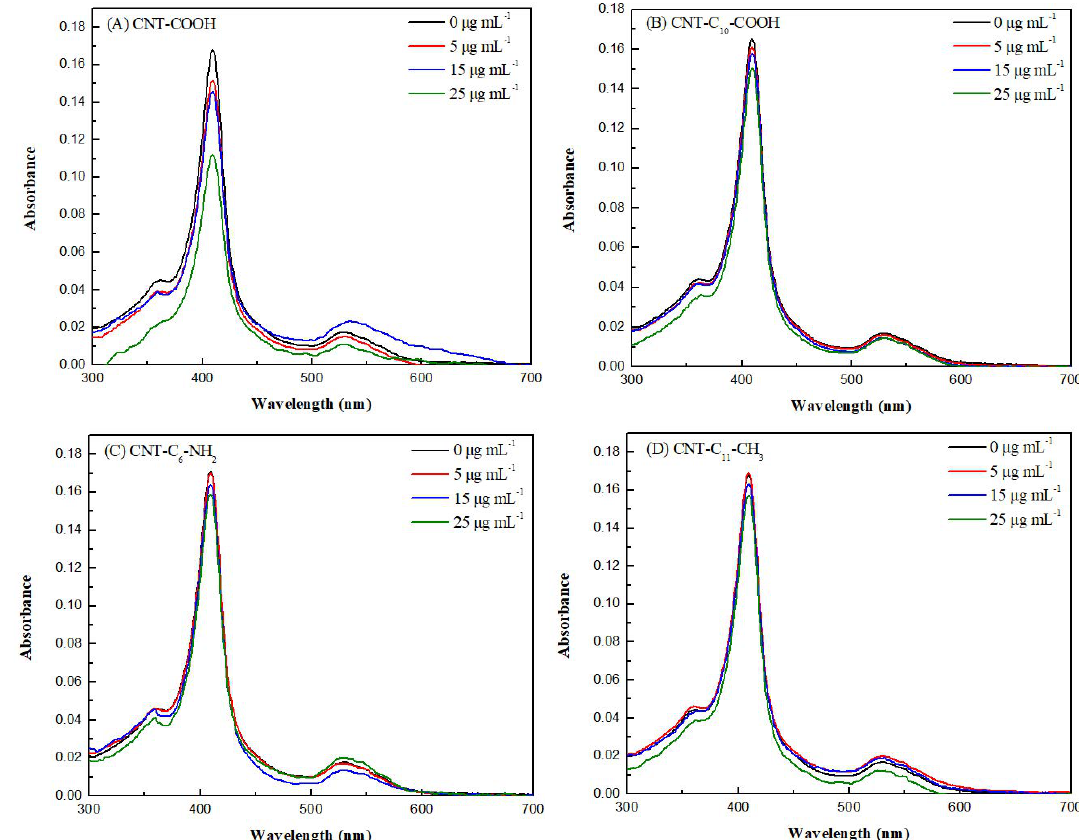
Fig. 4. Absorption spectra of cyt c in the presence of different concentrations of